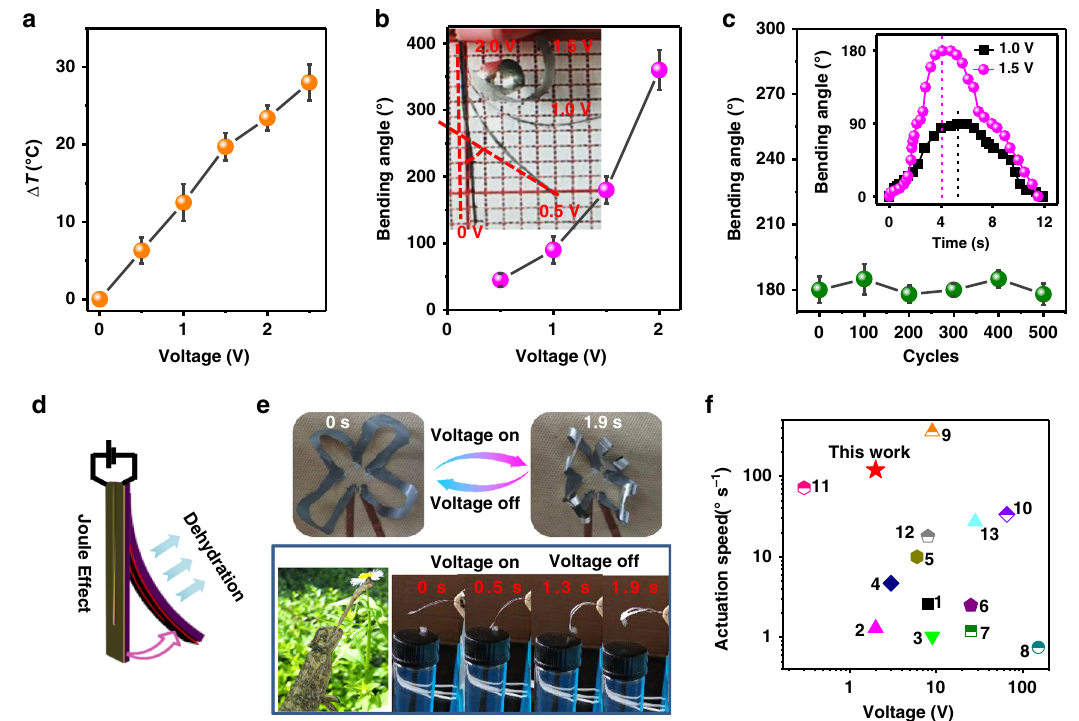
Fig. 3 Electrically-driven actuating behaviour of Janus fi lm. a Joule-heating effect at different voltages. 25 °C; Joule-heating effect ( Δ T : elevated temperature from 25°C) at different voltages. Rectangular fi lm of 24 × 2mm 2 ; EGaIn/CNFs layer thickness: 9/10 μ m/ μ m. b Bending angles at